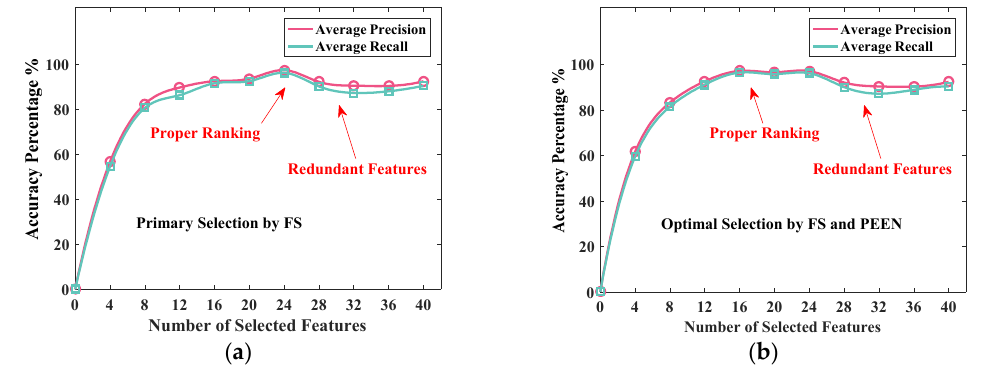
Figure 10. Identification accuracy results with different numbers of selected features. ( a ) Training result only by Fisher’s scoring method; and, ( b ) training result by Fisher’s score and the permutation entropy method.